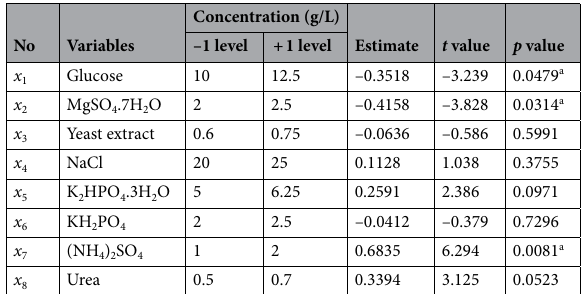
Table 3. Plackett–Burman design for the screening of variables at selected concentrations and the regression analysis. a Statistically significant at the confidence level of 95%.